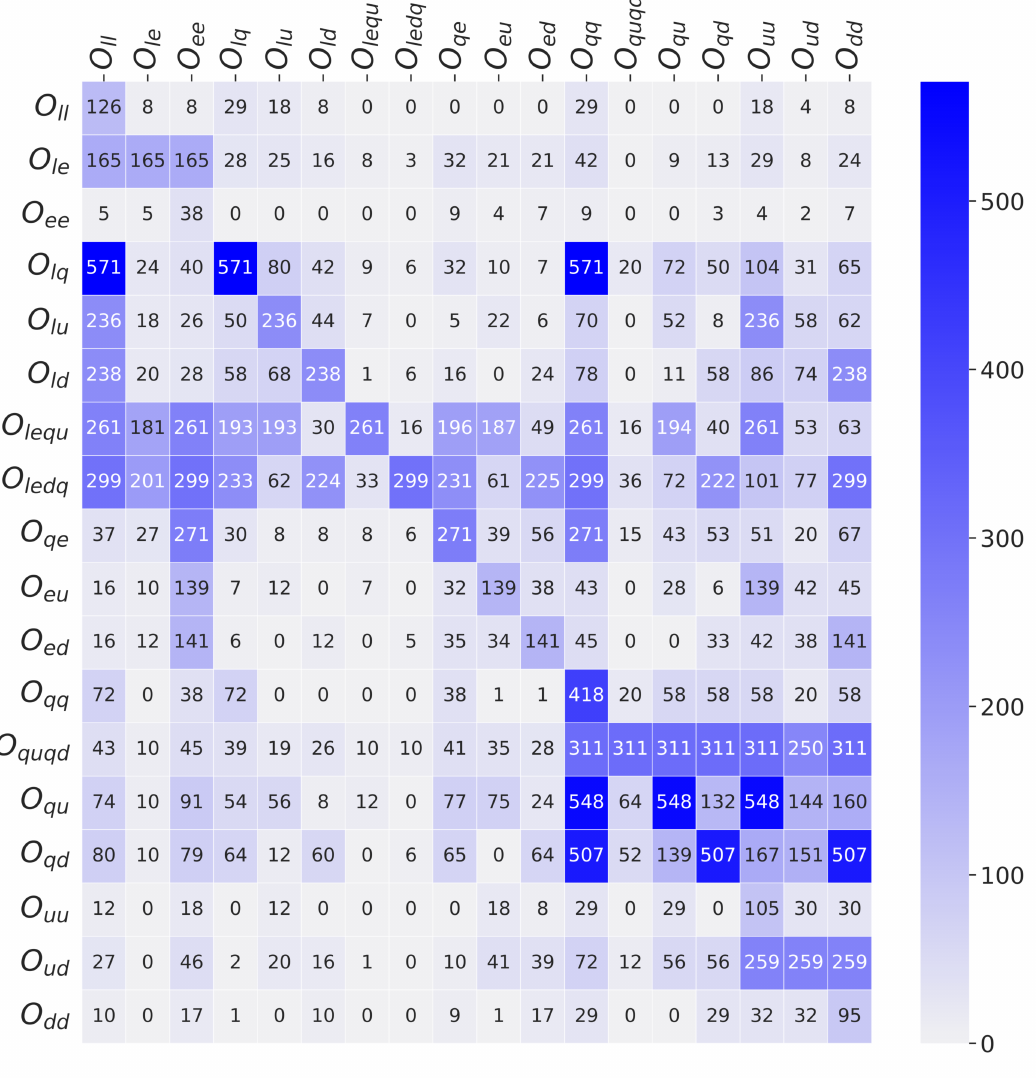
Figure 5. Operator overlap matrix for maxSU 3 = 8 , maxSU 2 = 6 and maxY = 5 . The table counts the number of models for each operator in the diagonal, the off-diagonal counts the “model overlap”, see